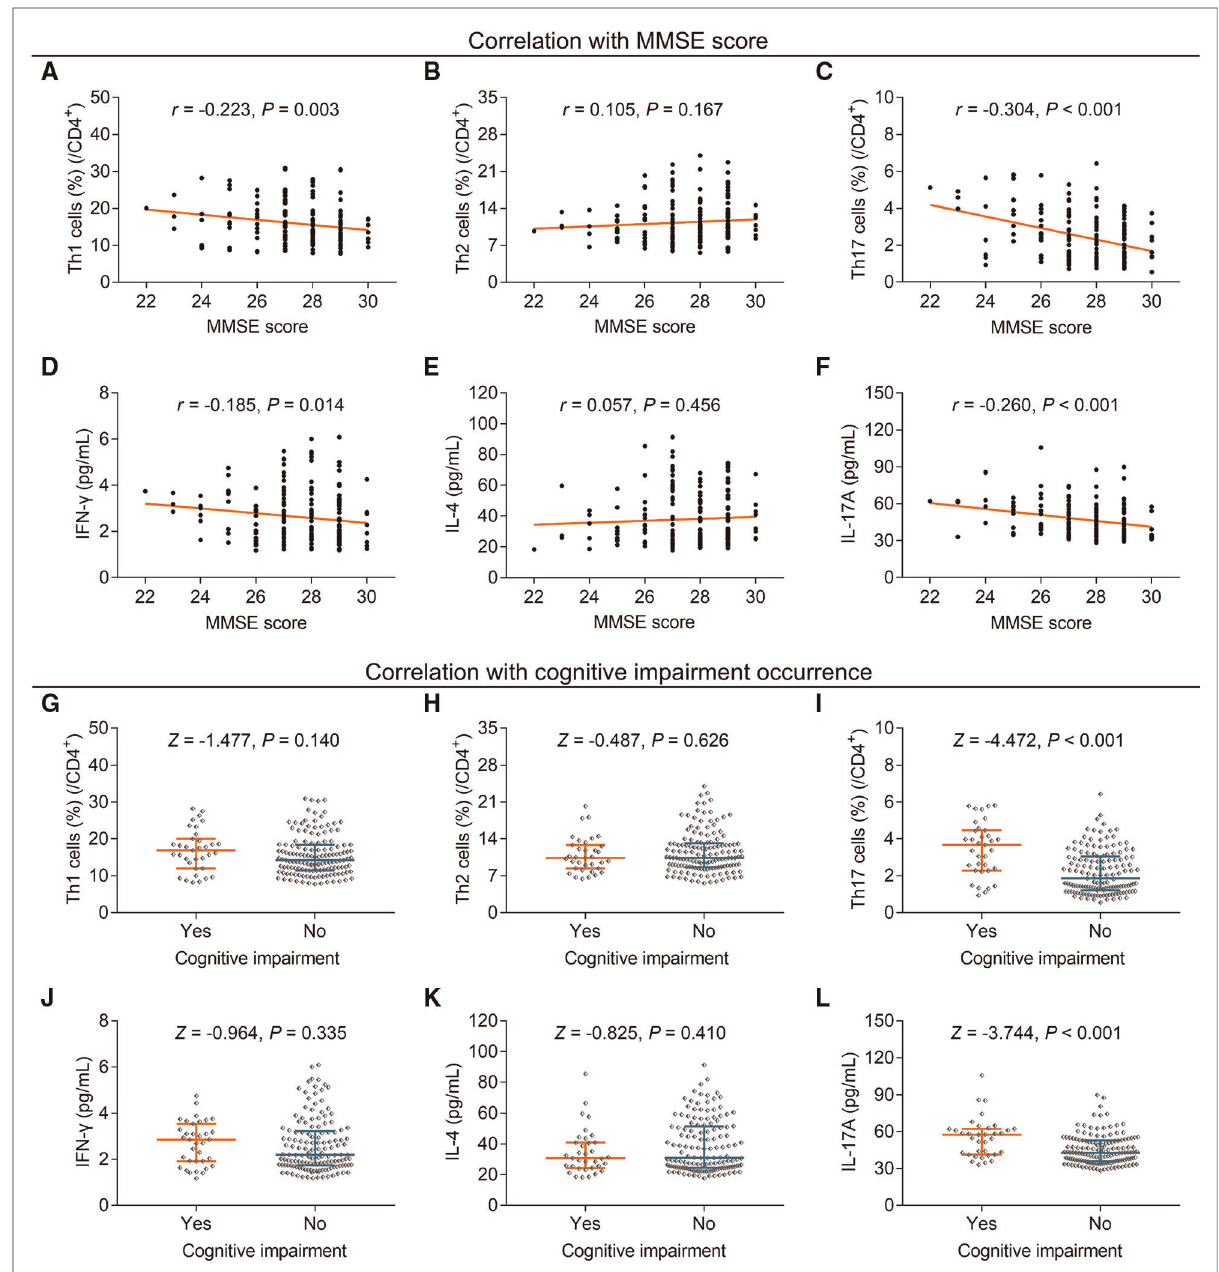
FIGURE 3 Correlation of Th1, Th2, and Th17 cells with cognitive impairment in elderly gastric cancer patients. Relationship between Th1 ( A ), Th2 ( B ), Th17 cells ( C ), IFN- γ ( D ), IL-4 ( E ), and IL-17A ( F ) and MMSE score; relationship between Th1 ( G ), Th2 ( H ), Th17 cells ( I ), IFN- γ ( J ), IL-4 ( K ), and IL-17A ( L ) with cognitive impairment occurrence in elderly gastric cancer patients. Statistical methods: associations between continuous variables were analyzed using Spearman ’ s rank correlation test; the levels of Th cells and cytokines between patients with or without anxiety, depression, and cognitive impairment were determined using the Wilcoxon rank-sum